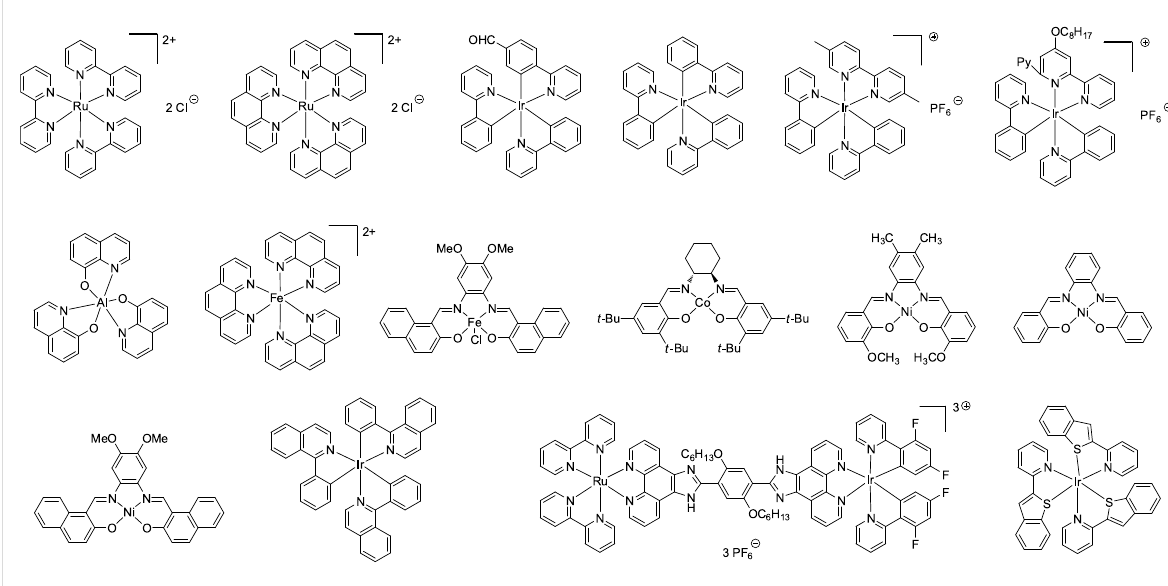
Figure 1: Previously reported PIC (based on metal complexes) [45-52].